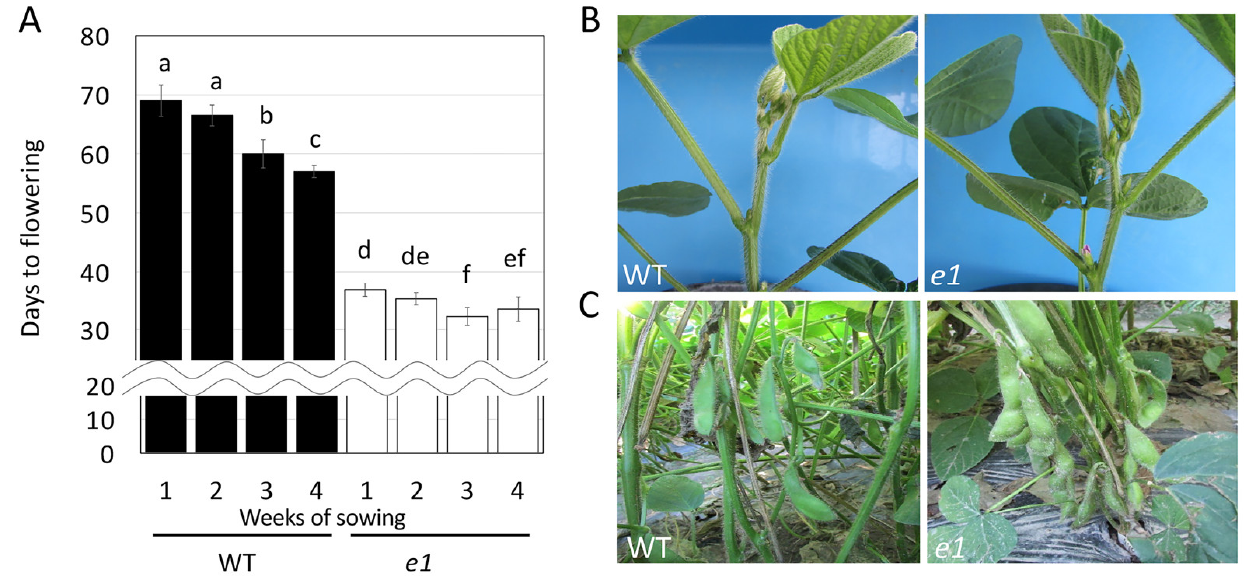
Figure 3. Flowering and harvest times for the wild type and e1 (17-0040) mutant. ( A ) Days to flowering for the wild type and e1 mutant sown once a week for four weeks starting in mid-May. Data are expressed as the average with standard deviation (n = 10). Values followed by different letters are statistically different at p < 0.05, as determined using Tukey’s HSD test. ( B ) Shoot apexes of the wild type and e1 mutant 35 days after sowing. The e1 mutant has flowered and the wild type has not formed buds. ( C ) Pods of the wild type and e1 mutant 80 days after sowing. The e1 mutant is at the optimum edamame harvest stage and the seeds of the wild type have not grown large.